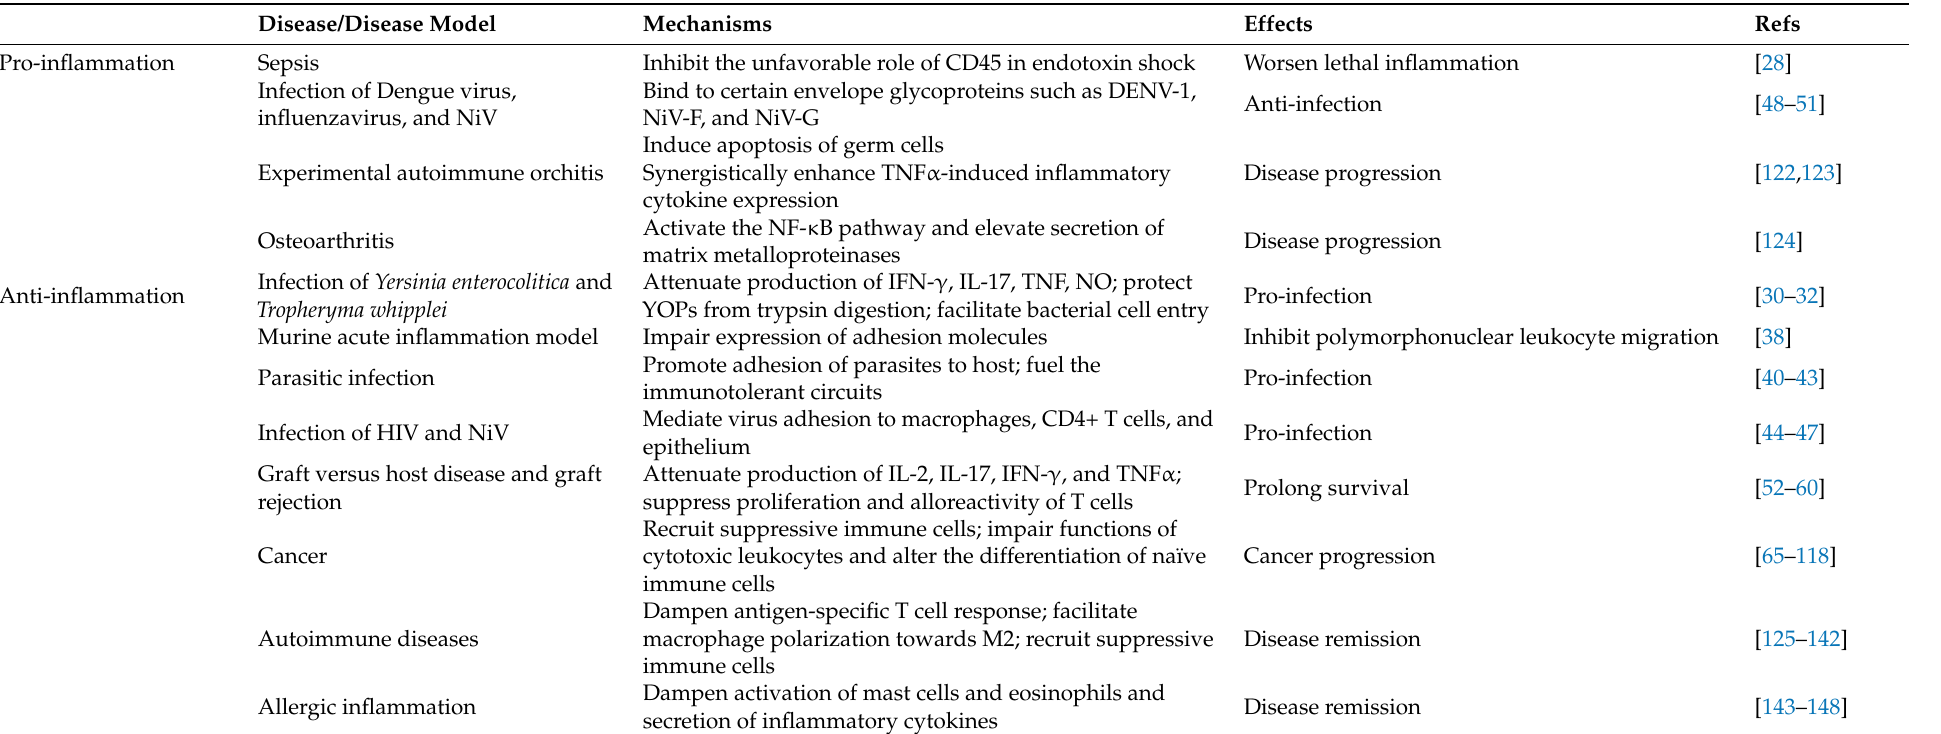
Table 2. The dual effects of galectin-1 in the immune